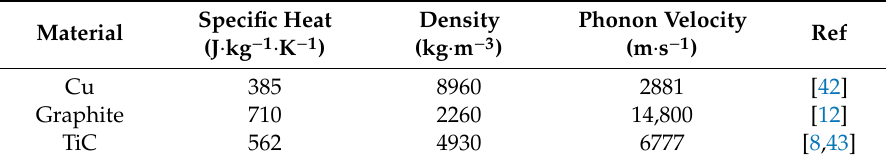
Table 1. Material parameters for theoretical